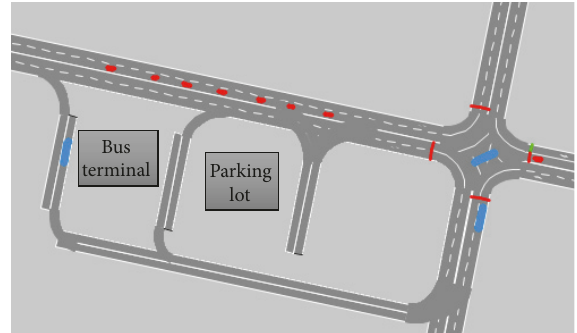
Figure 7: VISSIM network of alternative road geometry design.